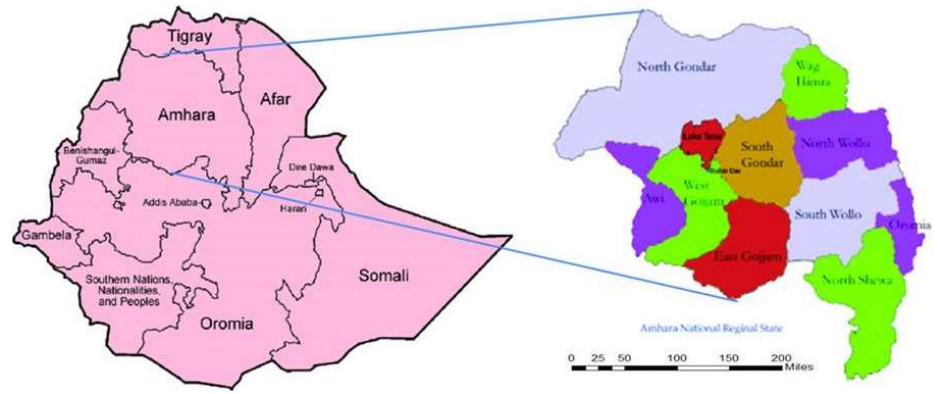
Figure 1. Amhara regional State, Ethiopia (2015/2016).